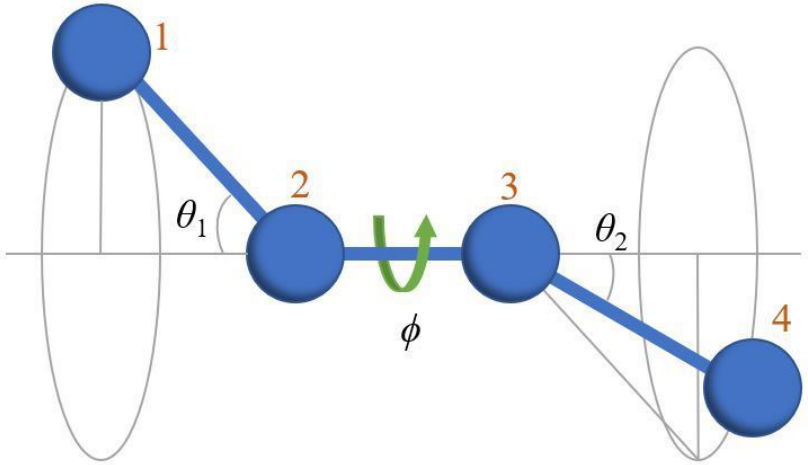
Figure A1. Definition of bending angles θ 1 , θ 2 , and torsion angle φ . The angle φ is measured with respect to the plane defined by bonds 1–2 and